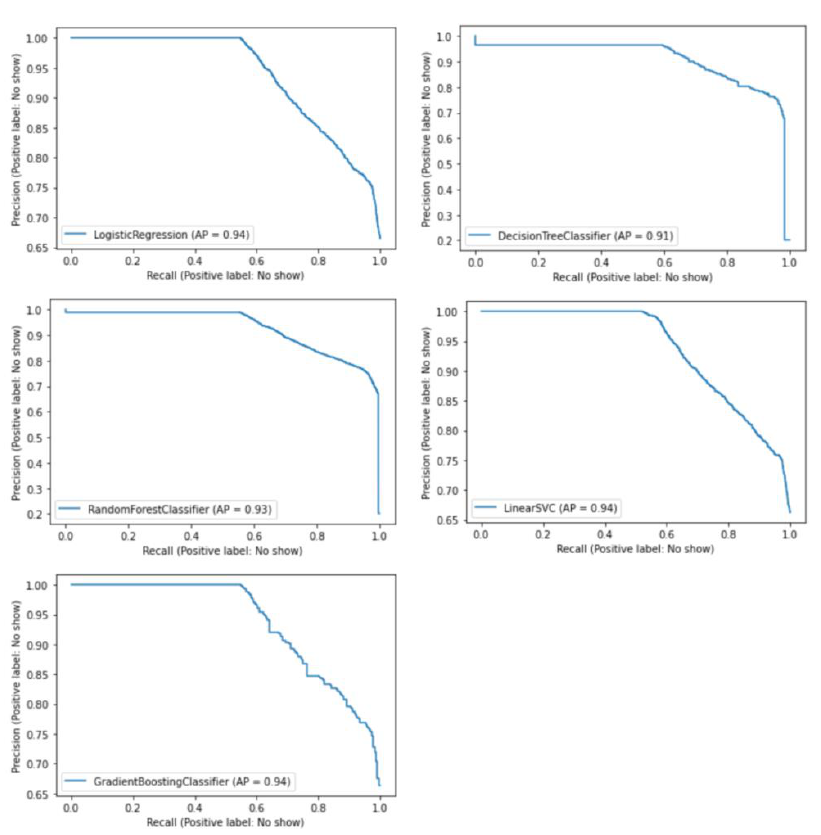
Figure 6. Precision -Recall Curve for different